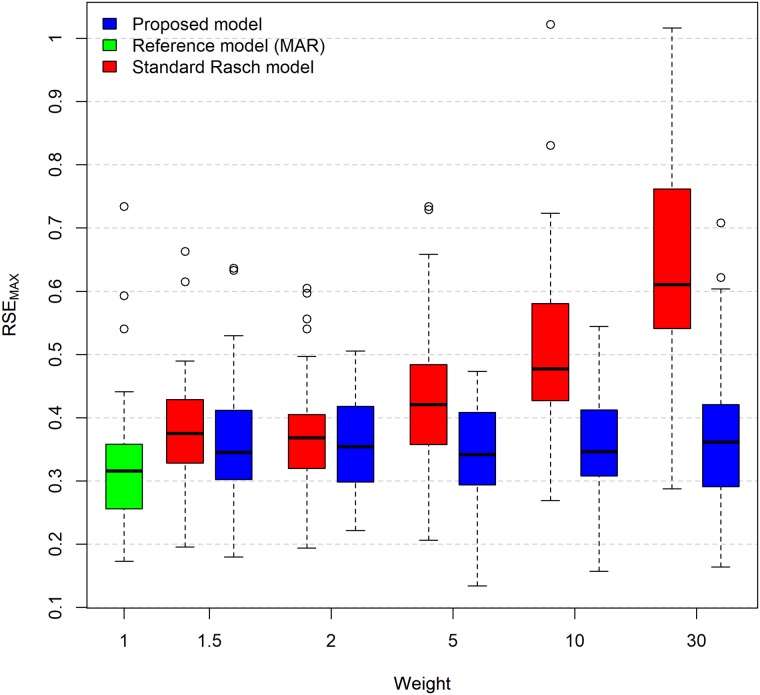
Boxplots of the RSEMAX for all the simulated weights of scenario 3.The blue boxplot represents the results from the proposed model, and the red boxplot represents the results from the standard Rasch model. The green boxplot is used as a reference and was obtained from the adjustment of the standard Rasch model in the data of scenario 1. In the boxplots, the lower outer contour of the rectangle indicates the first quartile (Q1), the upper outer contour of the rectangle indicates the third quartile (Q3), and the horizontal line inside the rectangle indicates the median (Q2). The vertical lines extended from the box indicate variability outside the first and third quartiles. The upper vertical line indicates the maximum observed value within the range [Q3; Q3+1.5×(Q3-Q1)]. The lower vertical line indicates the minimum observed value within the range [Q1; Q1-1.5×(Q3-Q1)]. Observations beyond the vertical lines are represented as points and indicate outliers.